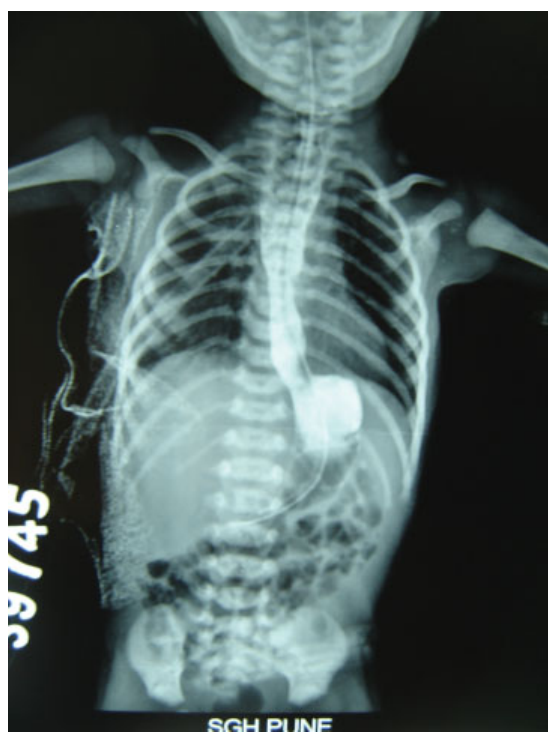
Fig. 3 Contrast study showing a widely patent anastomosis and no anastomotic